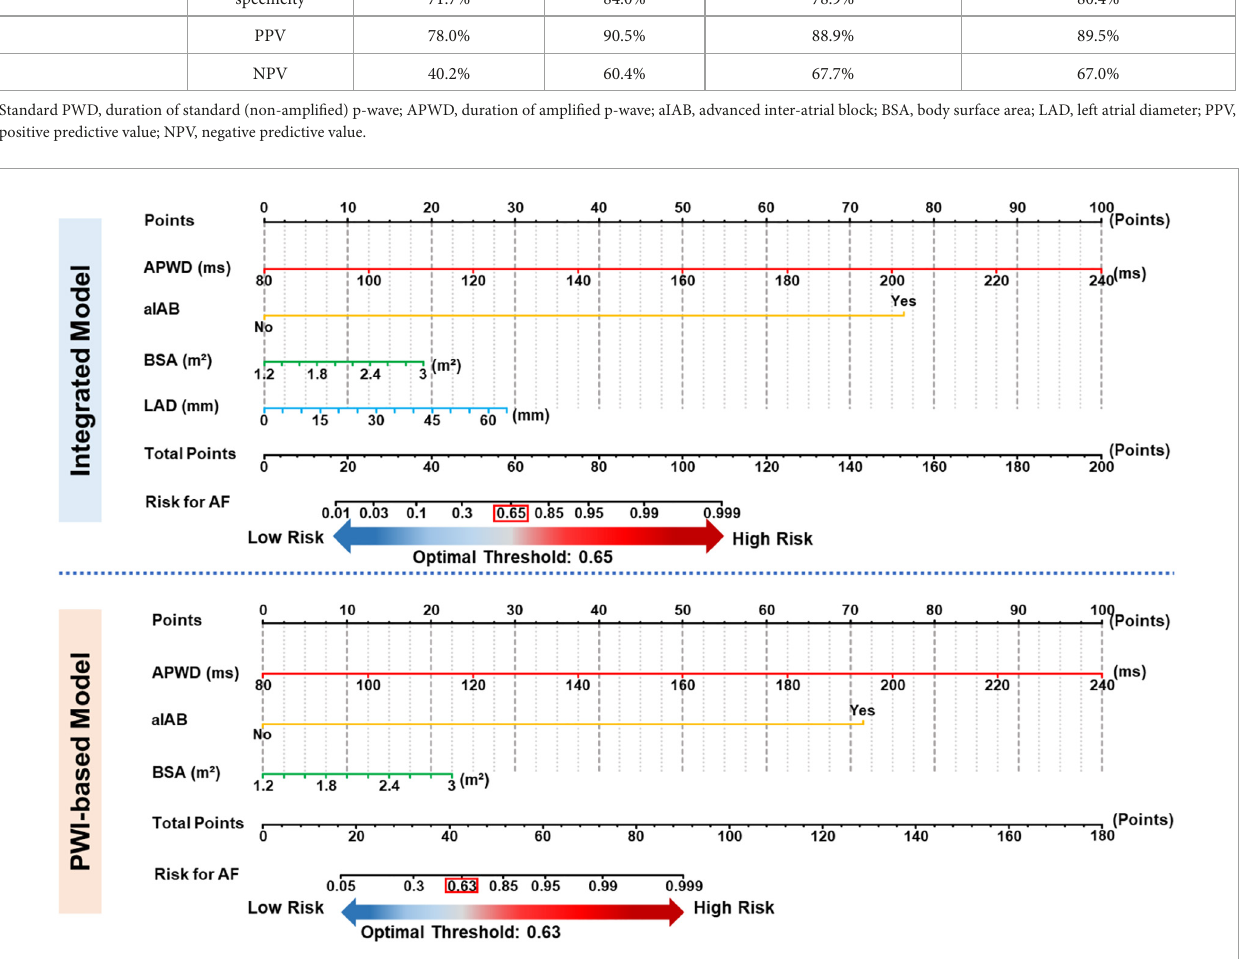
patients with AF. (2) Integration of APWD with IAB, and BSA allowed development of a multi-variable PWI-based model with optimal performance for identification of patients with AF. (3) Addition of echocardiographic left atrial diameter to the PWI-based model further improved the diagnostic power for